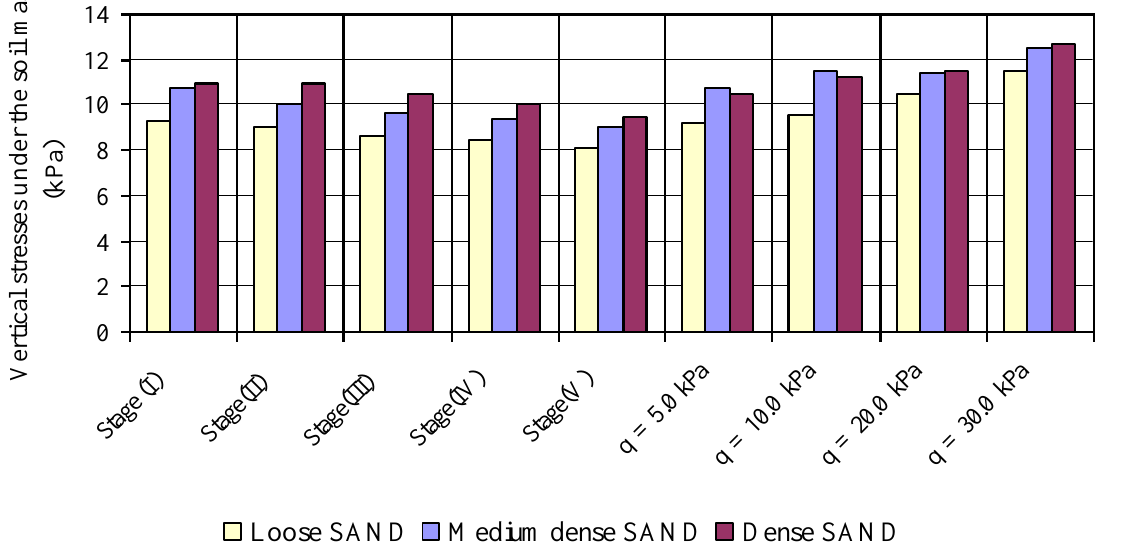
Figure 8. Influence of soil density on the vertical stresses under the nails.